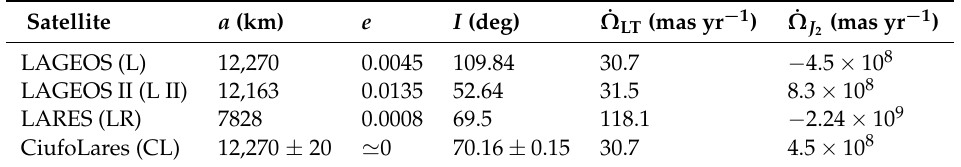
Table A1. Relevant orbital parameters a , e , I , LT and J 2 -driven node precessions ˙ Ω LT , ˙ Ω J existing satellites of the LAGEOS family and of CL along with the orbital offsets for the latter quoted in Ciufolini et al. [38]. The values for the classical and relativistic node precessions of CL are calculated for its nominal orbital configuration.